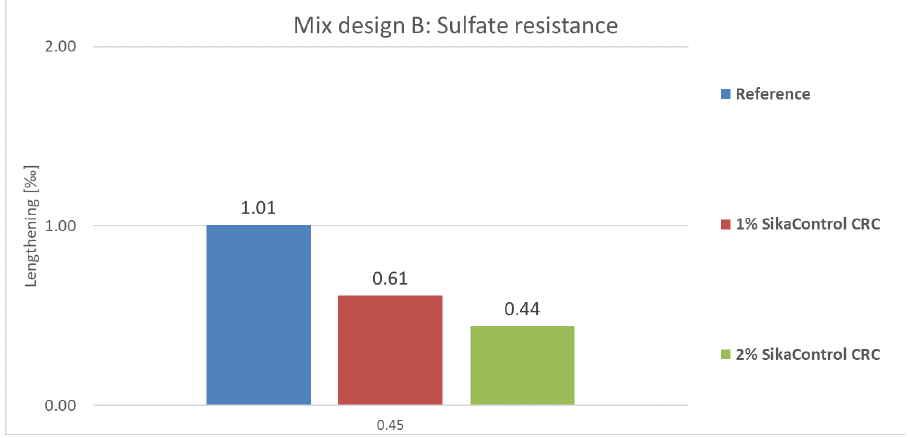
Figure 6. Mix design B: Sulfate resistance.